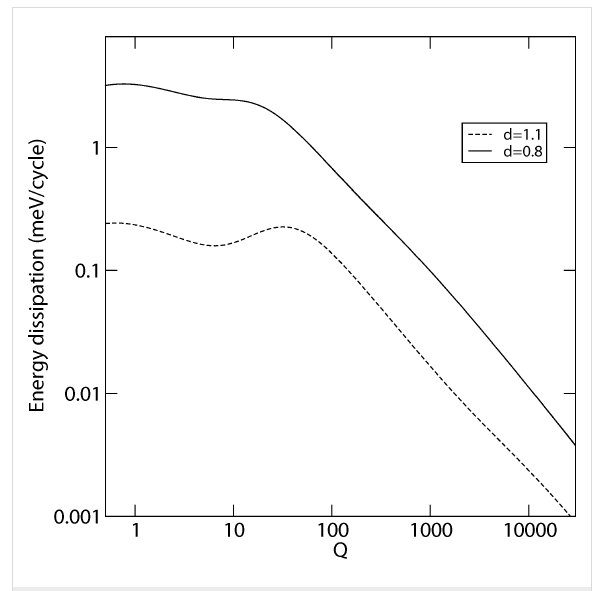
Figure 6: Dissipation rate with respect to the variation of the Q-factor for nominal distances of d = 0.8 nm and d = 1.1 nm. Numerical simula- tion for 300 normal cycles with the default parameter